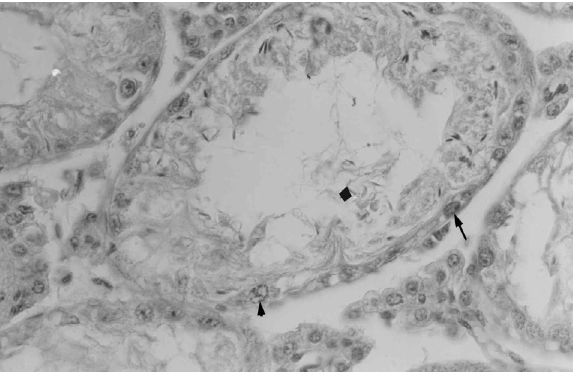
Figure 1 - Photomicrography of the seminiferous tubules of the testis of Swiss albino mice treated orally with C. cajucara extract (1250 mg kg -1 body weight) and injected intraperitoneally with cyclophosphamide (150 mg kg -1 bw). Note sertolization in the epithelium (arrow), sparse spermatogonia (arrow head) and rare spermatozoids ( (cid:1) ). Hematoxilin- eosin,